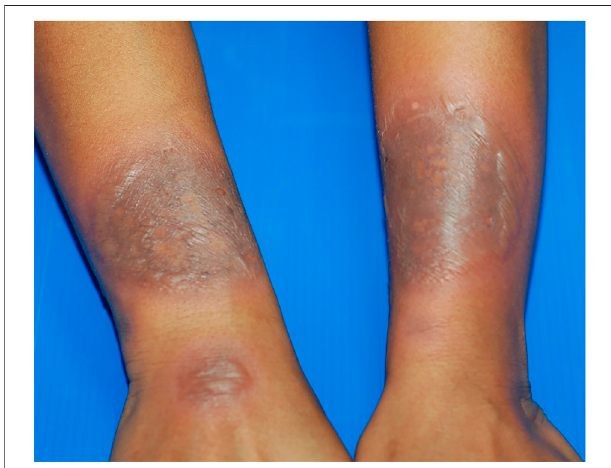
FIGURE 4 | Generalized bullous fi xed drug eruption (GBFDE). Multiple large and well-demarcated round to oval plaques with blisters formation. The lesions were found at different sites of the body. Fewer than two sites of the mucousmembranewereinvolved.Thepatienthasexperiencedasimilar reaction in the past.